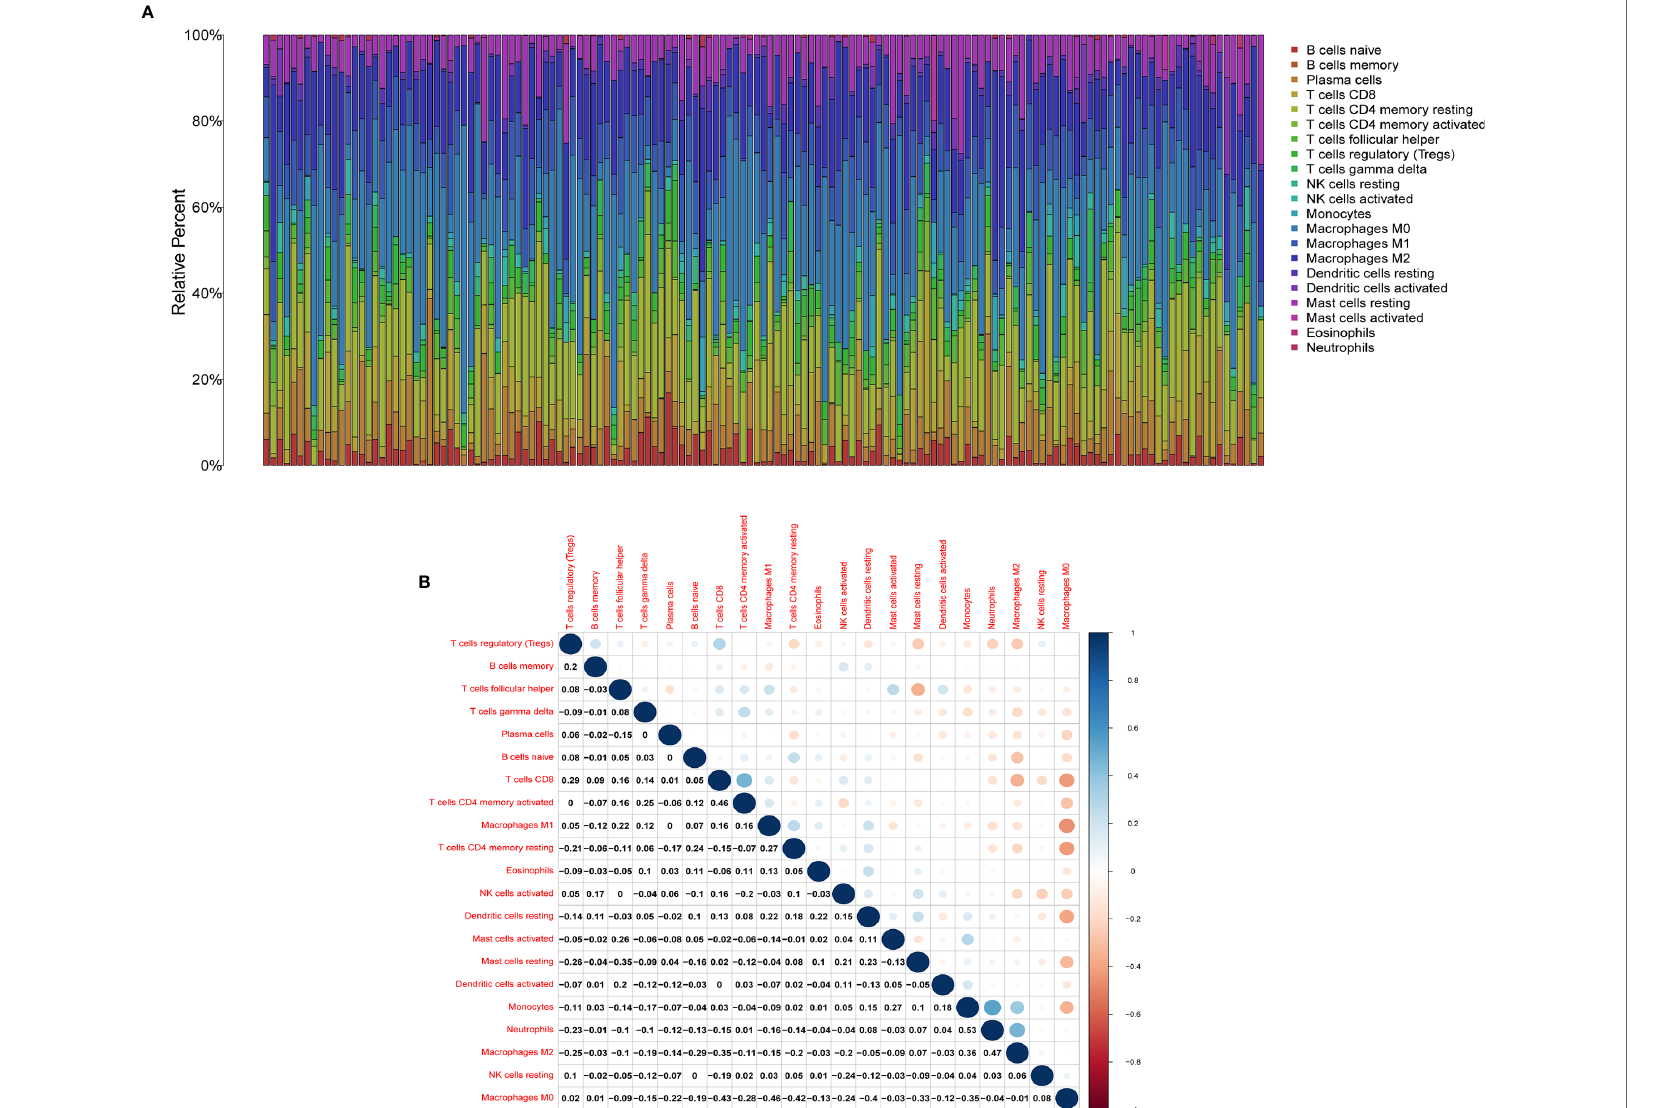
FIGURE 6 | TIC pro fi le in tumor samples and correlation analysis. (A) Barplot showing the proportion of 21 kinds of TICs in HER2+ BC samples. (B) Heatmap showing the correlation between 21 kinds of TICs and numerals in each small box indicating the p value of correlation between two kinds of cells. The shade of each small color box represents the corresponding correlation value between two cells, and the Pearson coef fi cient was used for signi fi cance